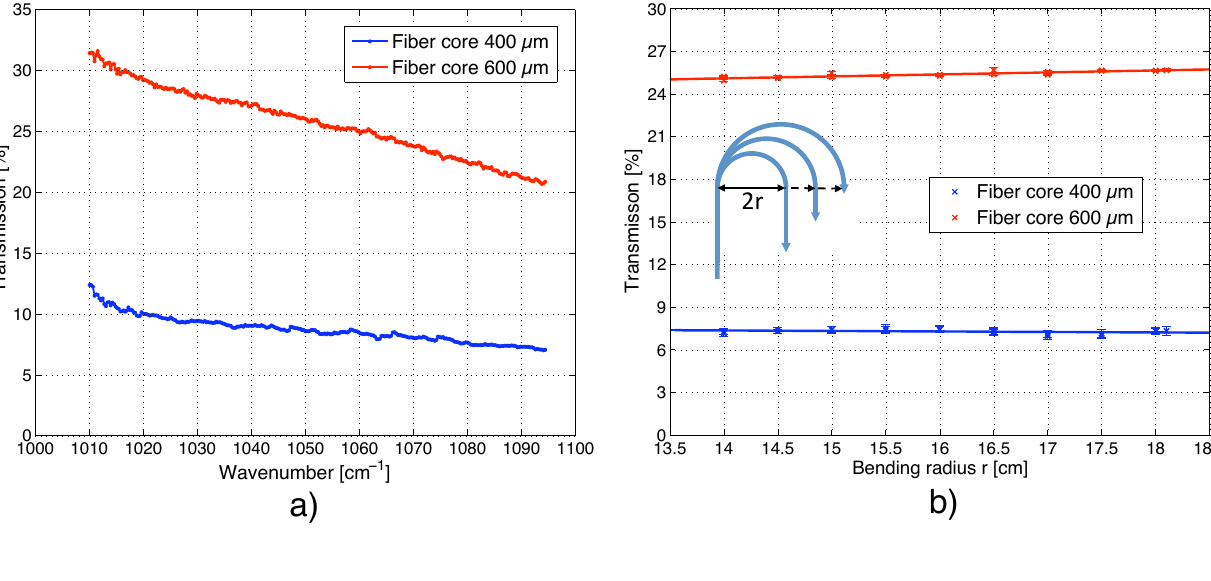
Figure 4. ( a ) Wavelength dependence of the transmission of the MIR fiber; ( b ) Variation of the fiber transmission at 1055 cm − 1 upon changing the bending radius of the